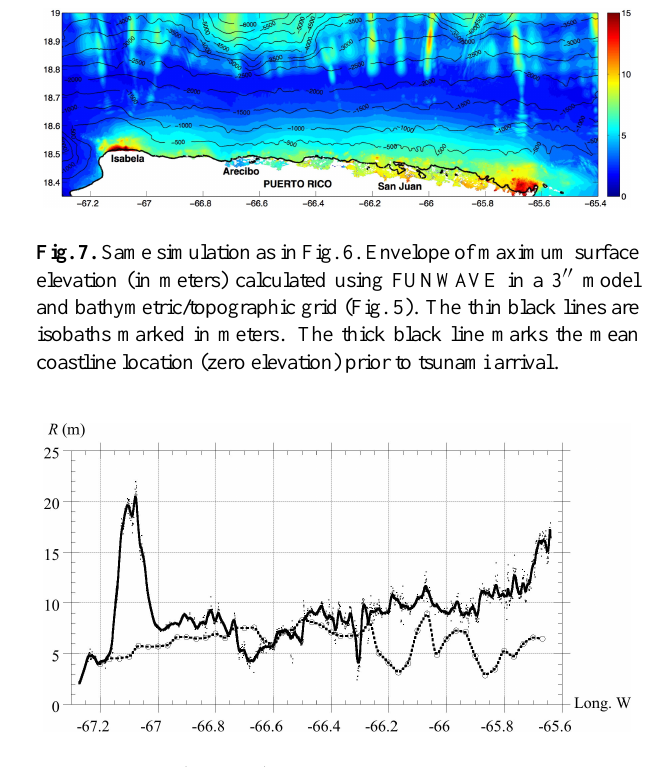
Fig. 8. Runup (in meter) along PRNS, for the M =9.1 co-seismic tsunami source, calculated with FUNWAVE in a 3 00 (.——.) (Figs. 6 and 7) and 2 0 (o- - -o) model grid, for the 3 00 resolution topography and bathymetry of Fig. 5. For clarity, solid lines denote smoothed curves based on computational data represented by scattered sym- bols.